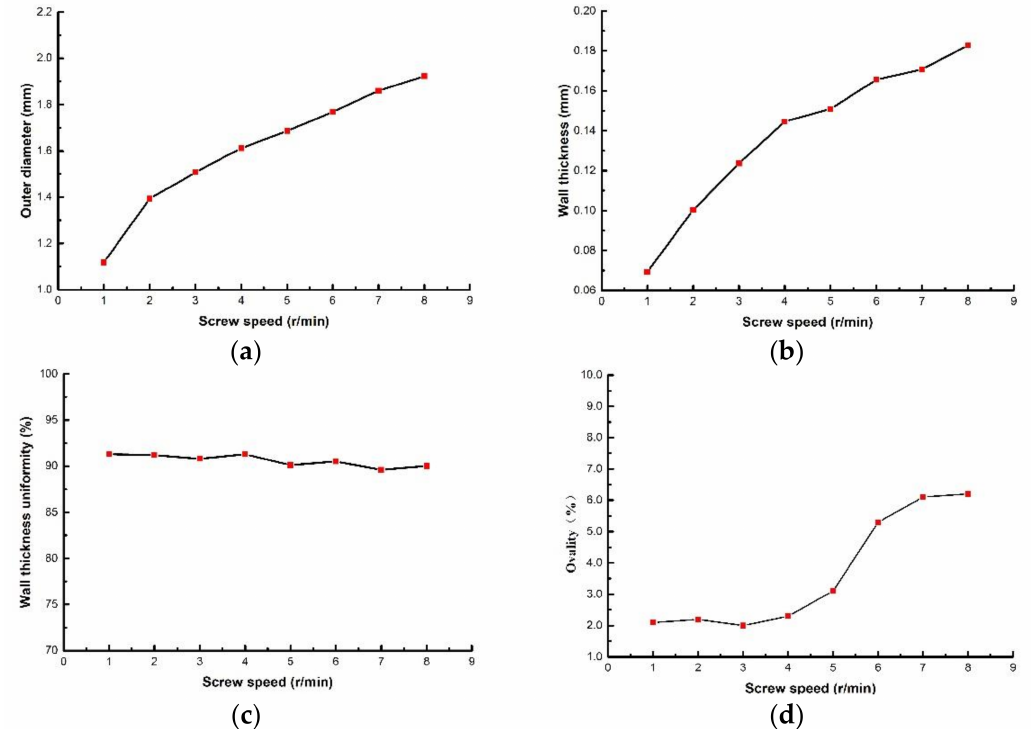
Figure 6. The relationships between evaluation index with screw speed: ( a ) The relationship between outer diameter with screw speed; ( b ) The relationship between wall thickness with screw speed; ( c ) The relationship wall thickness uniformity with screw speed; ( d ) The relationship between ovality with screw